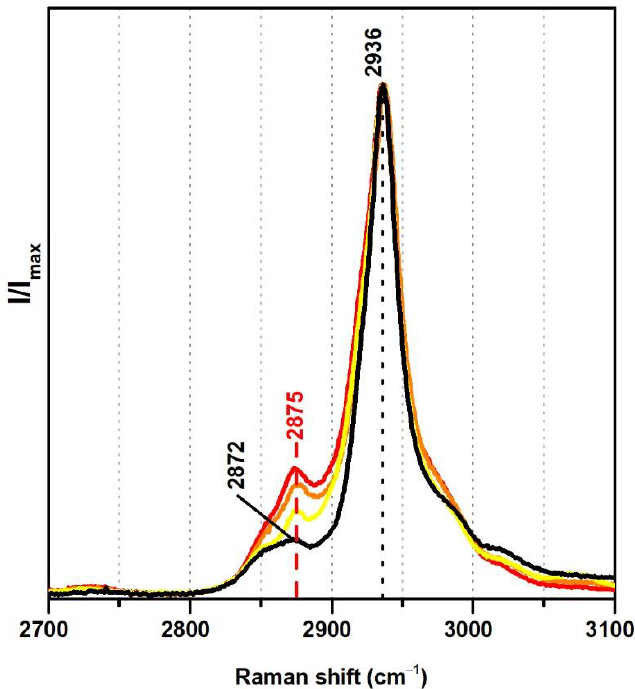
Figure 4. Raman spectra of the pure PVAc emulsion (black), Polidisp DM21 (red), Polidisp DM23 (orange), and Imofan AV44/11 (yellow). According to technical data sheets, these Polidisp commercial formulations are composed of P(VAc-VeoVa) and, according to the work in [5], the Imofan AV44/11 is composed of P(VAc-VeoVa) plasticised with DiBP. Table 2. Raman intensity ratios for the symmetric and antisymmetric CH 2 bonds in vinyl-acetate based emulsions with and without VeoVa in the formulation.